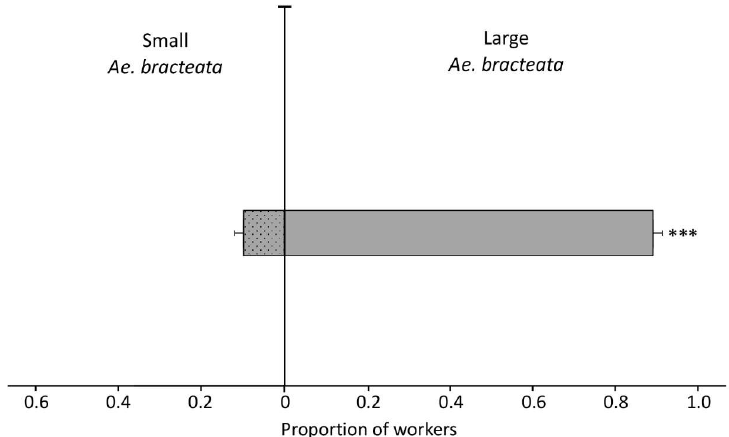
Figure 4. Mean proportion of N. villosa workers ( ± SEM) in bioassays with two Ae. bracteata plants of di ff erent sizes, large (80 cm) vs. small (25 cm). All workers tested were originally nesting in Ae. bracteata (n = 29 trials). *** p < 0.0001, GLMM.